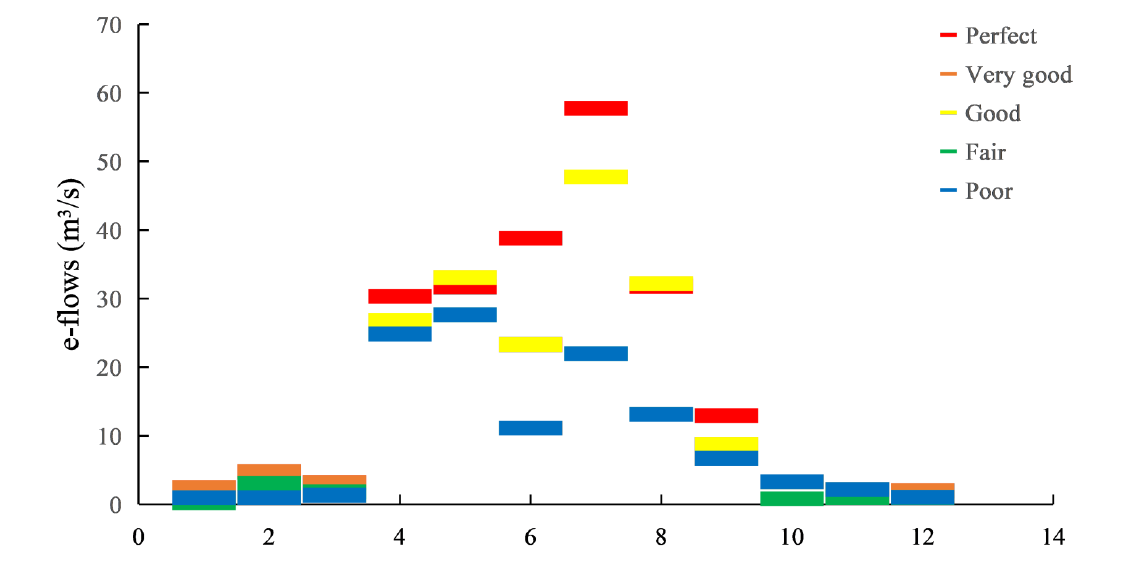
Figure 6. Optimized e-flow results based on MEA.